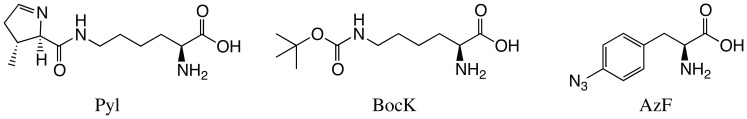
The structures of Pyl, BocK and AzF.